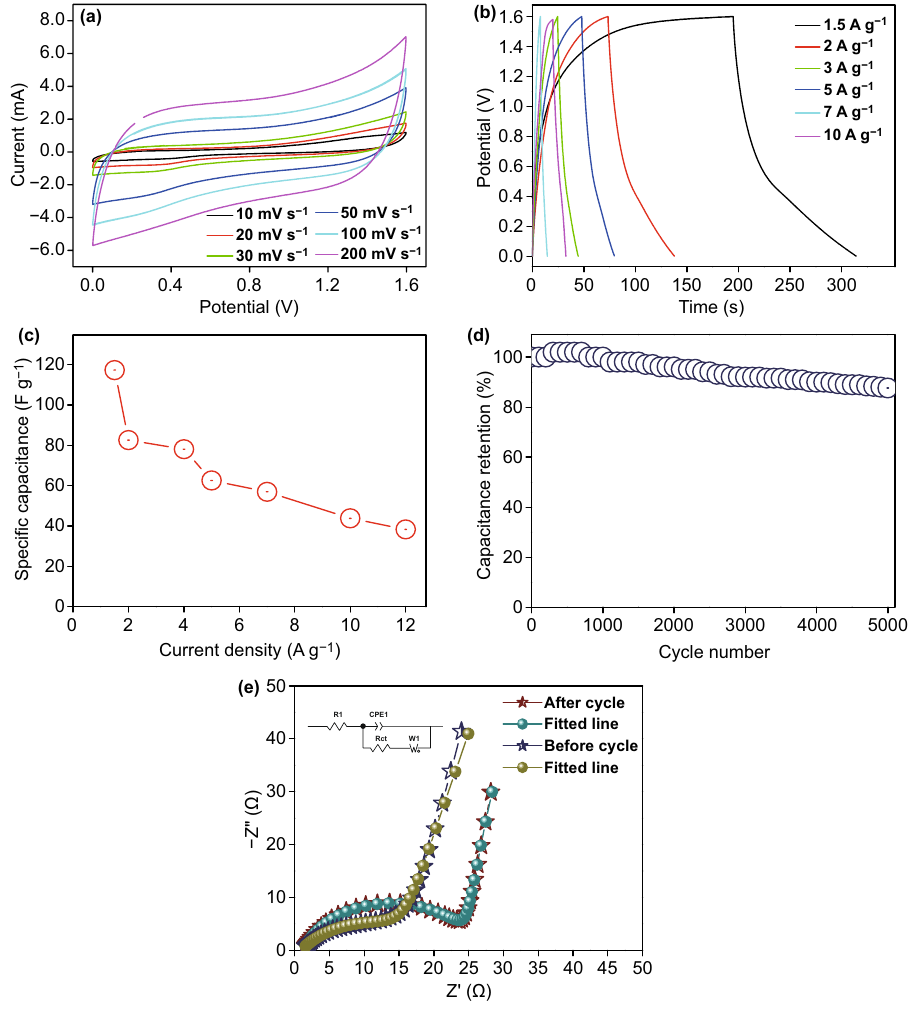
Fig. 10 a CV profile of the assembled device at various scan rates. b Galvanostatic charge/discharge profile of the device at various current den‑ sities. c Specific capacitance of the assembled device at various current loads. d Cycling stability test of the device in the inset showing the GCD profile of the last complete cycle. e Nyquist plot of the assembled device before and after the cycling stability test (inset: